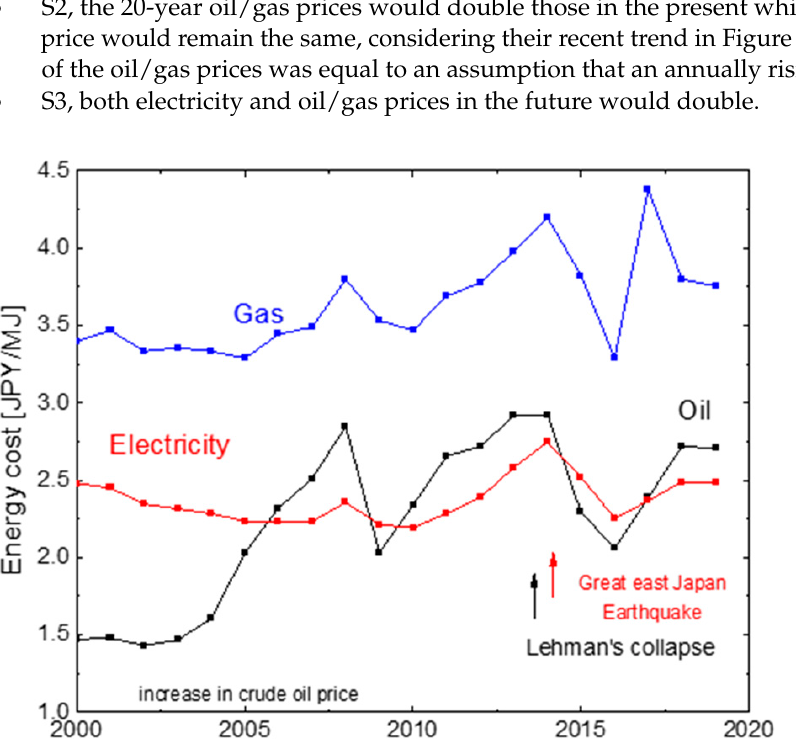
Figure 10. Current 20-year trends of oil, gas, and electricity prices in Japan.